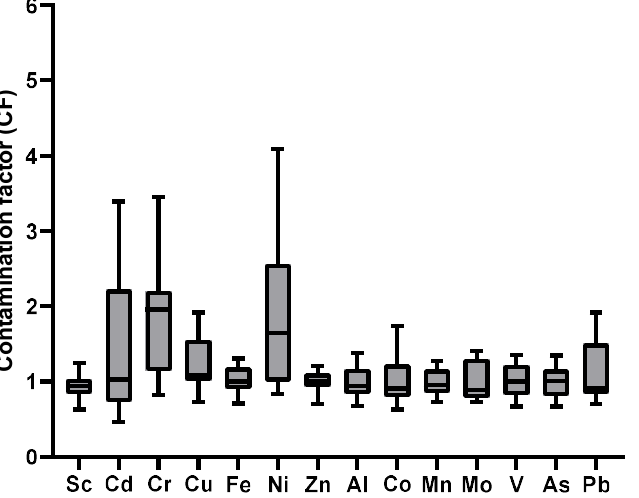
Figure 3. Box plot of the contamination factor for studied PTE in agricultural soils.